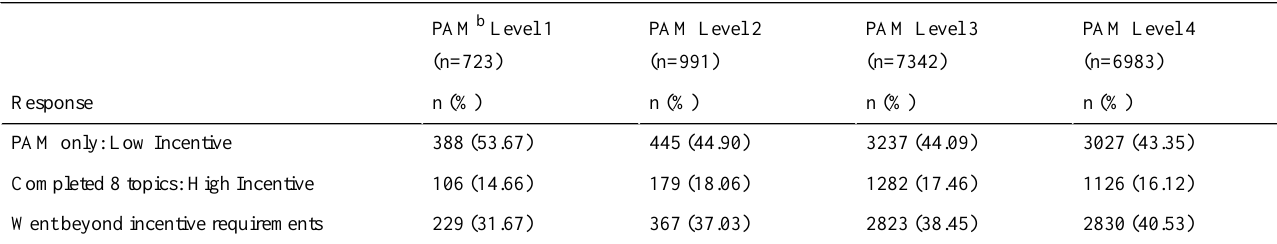
Table 3. Patient activation level and response to incentive.